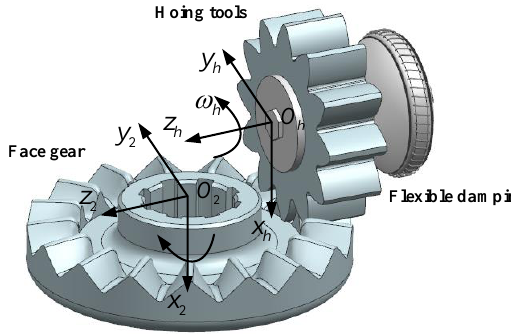
Figure 4. Principle of face-gear honing.